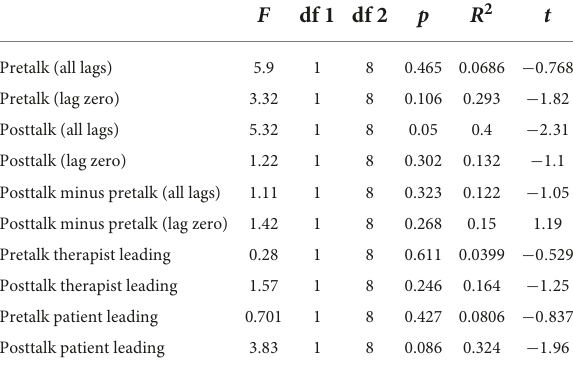
TABLE 5 Correlations between nonverbal synchrony and patients’ self-reported therapy